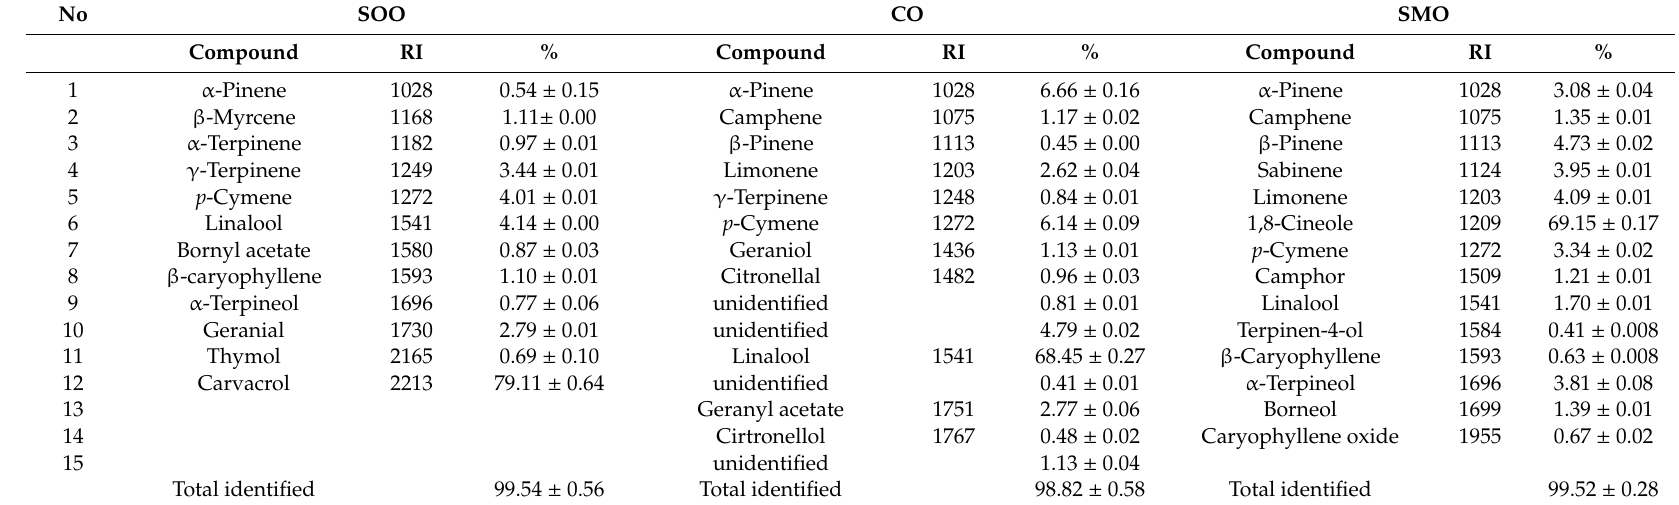
Table 2. Gas chromatographic composition (% peak area) of Spanish origanum oil (SOO), coriander oil (CO) and Spanish marjoram oil (SMO) (% of